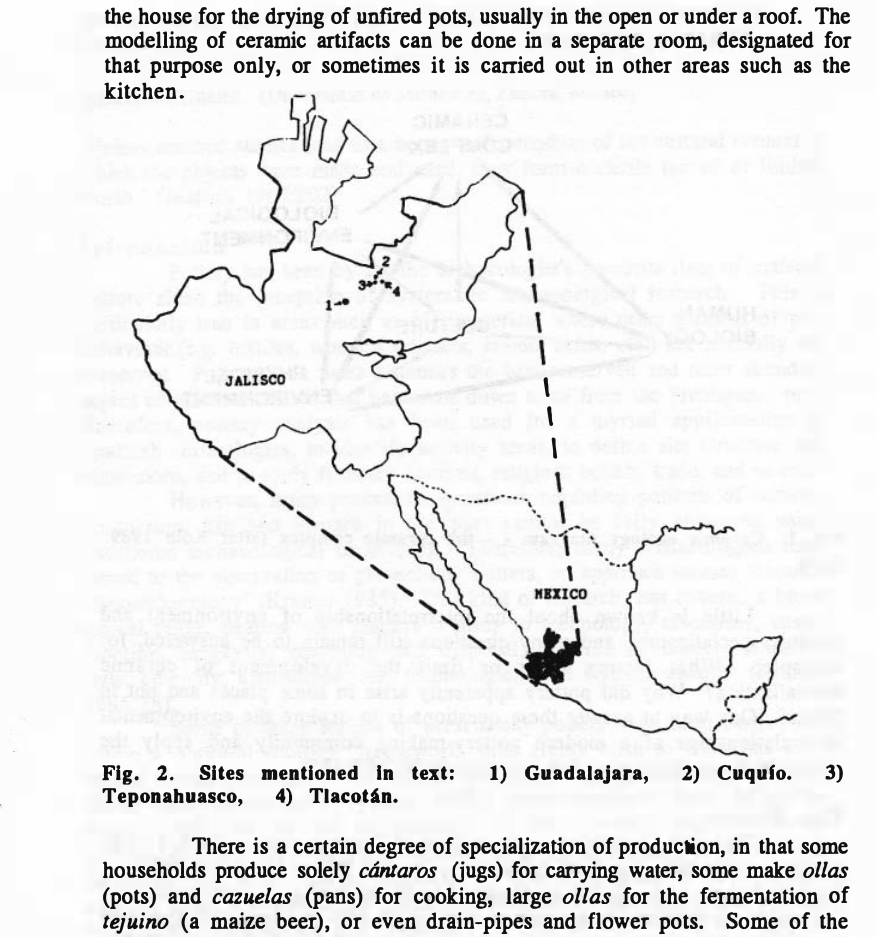
Fig. 2. Sites mentioned In text: 4) Teponahuasco,